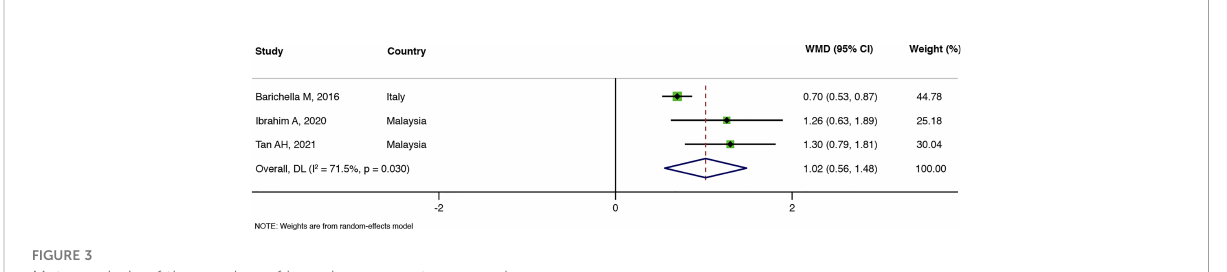
FIGURE 3 Meta-analysis of the number of bowel movements per week.